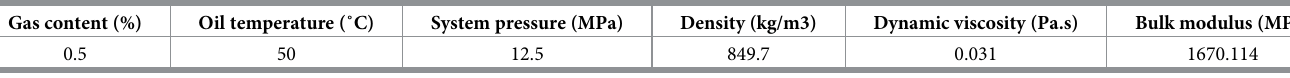
Table 4. 46# mineral oil media